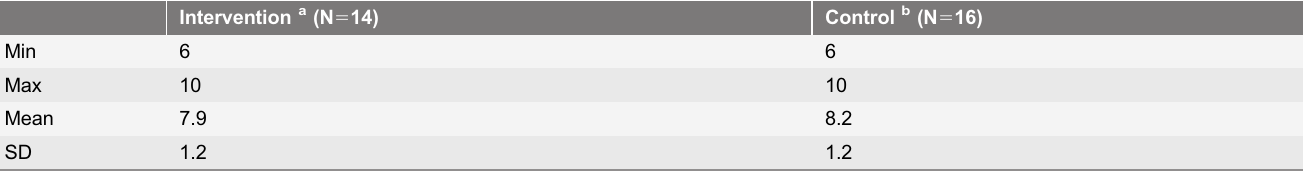
Table 4. Perceived goal attainment on plans concerning chronic care management 1